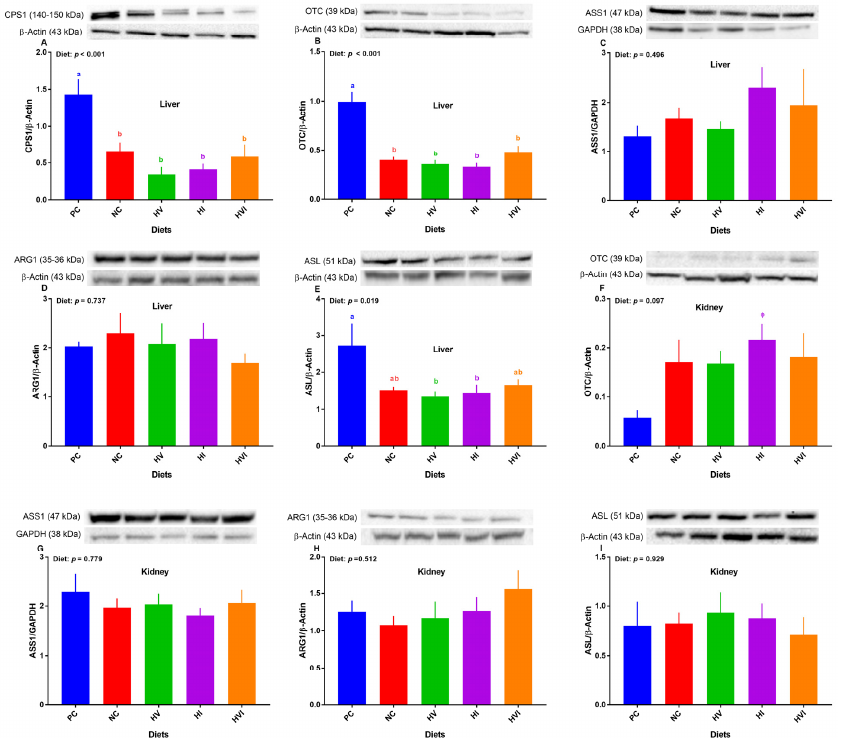
Figure 5. Relative protein abundance of urea cycle enzymes in the liver ( A – E ) and kidney ( F – I ) of nursery pigs fed with very low protein diets containing isoleucine (Ile), valine (Val), or mix of both above NRC levels. ( A ) carbamoyl phosphate synthetase I (CPS1 ), ( B , F ) ornithine transcarbamylase (OTC) , ( C , G ) argininosuccinate synthase I (ASS1) , ( D,H ) arginase I (ARG1), and ( E , I ) argininosuccinate lyase (ASL). GAPDH and β -actin were selected as a loading control. PC: positive control, standard protein diet; NC: negative control, very low protein diet containing the first four limiting amino acids (i.e., lysine, methionine, threonine, and tryptophan) at NRC levels; HV: NC containing Val above NRC level; HI: NC containing Ile above NRC level; and HVI: NC containing both Val and Ile above NRC level. The values are means ± standard error of the mean. a,b,ab Among groups, the means with different superscript letter(s) are different ( p ≤ 0.05). n = 8. φ p ≤ 0.1 HI vs.